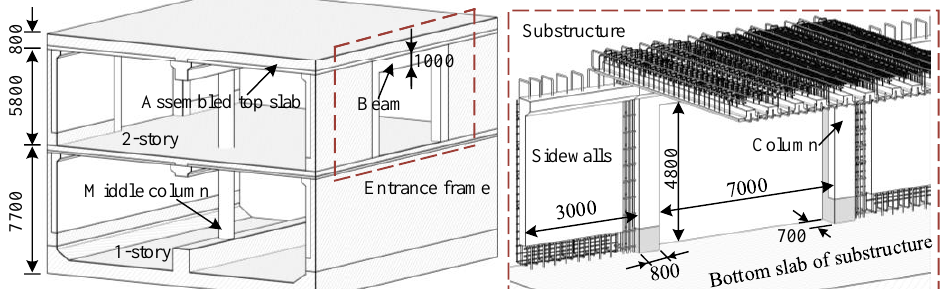
Figure 2. Schematic illustration of the full-scale subway station (units: mm).